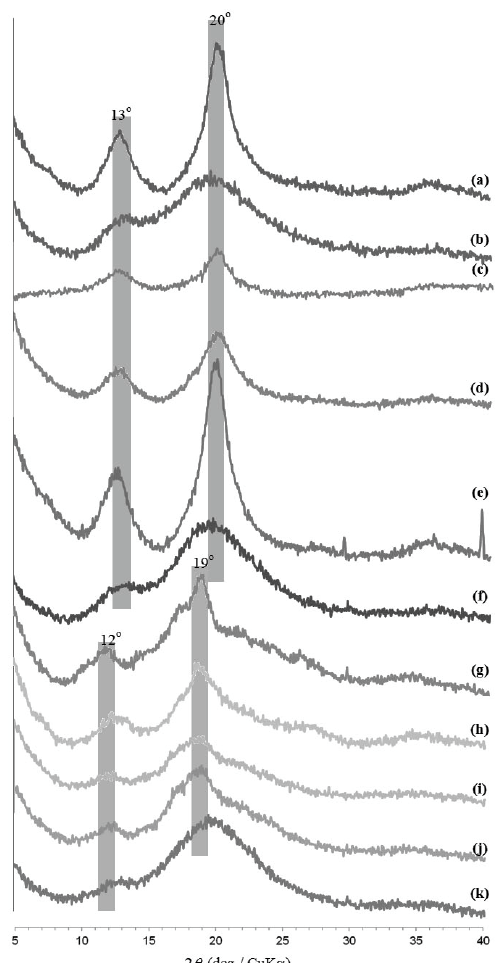
Figure 3. X ‐ ray diffraction (XRD) profiles of: ( a ) amylose–PTHF inclusion complex; ( b ) chloroform ‐ insoluble fraction by its treatment in DMSO at 25 °C; ( c ) amylose–PCL inclusion complex, chloroform ‐ insoluble fractions by its treatment in DMSO at ( d ) 25 °C, ( e ) 30 °C, and ( f ) 40 °C; ( g ) amylose–PLLA inclusion complex, chloroform ‐ insoluble fractions by its treatment in DMSO at ( h ) 25 °C, ( i ) 30 °C, ( j ) 40 °C, and (k) 60 °C.